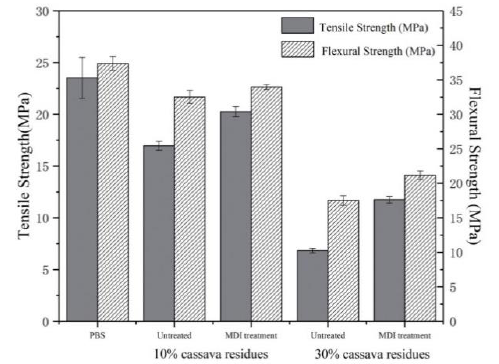
Figure 4. Effect of 4,4’-methylene diisocyanate phenyl ester (MDI) modification of cassava residues on mechanical properties of composites.